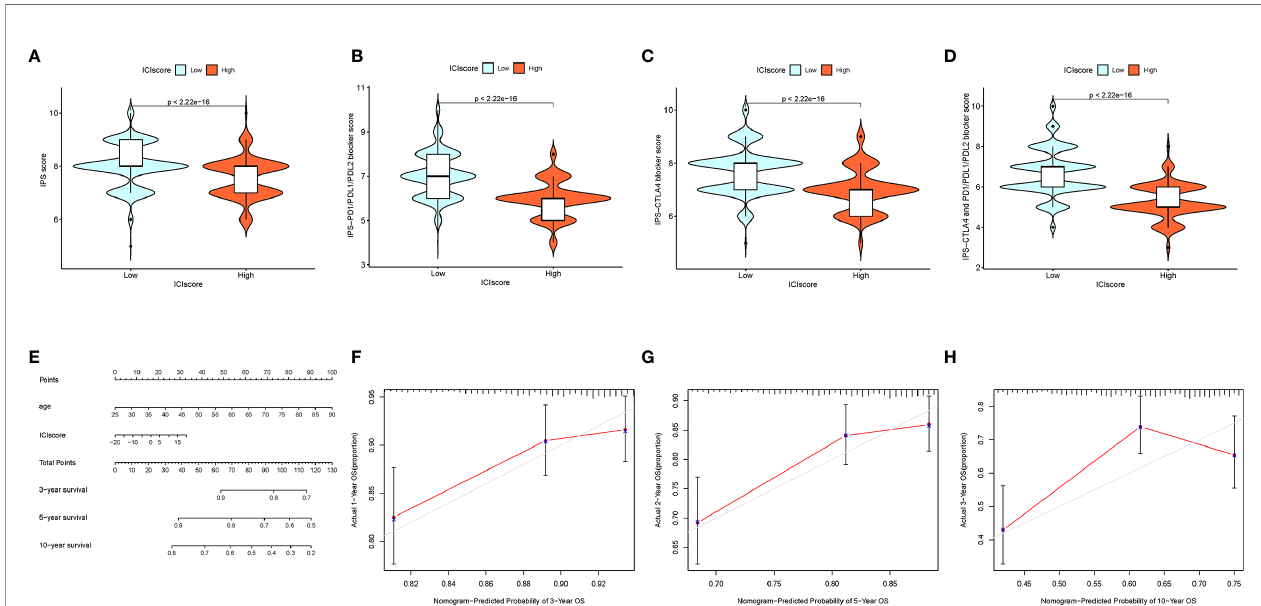
FIGURE 9 | The Estimation of the ICI Score in Immunotherapy Response. (A) IPS score distribution plot. (B) IPS – CTLA4 blocker score distribution plot. (C) IPS – PD1/PDL1/PDL2 blocker score distribution plot. (D) IPS – CTLA4 and PD1/PDL1/PDL2 blocker score distribution plot. (E) Nomogram was assembled by age and risk signature for predicting survival of BRCA patients. (F) Three ‐ year nomogram calibration curves of the combination of the TCGA and GEO cohorts. (G) Five ‐ year nomogram calibration curves of the combination of the TCGA and GEO cohorts. (H) Ten ‐ year nomogram calibration curves of the combination of the TCGA and GEO